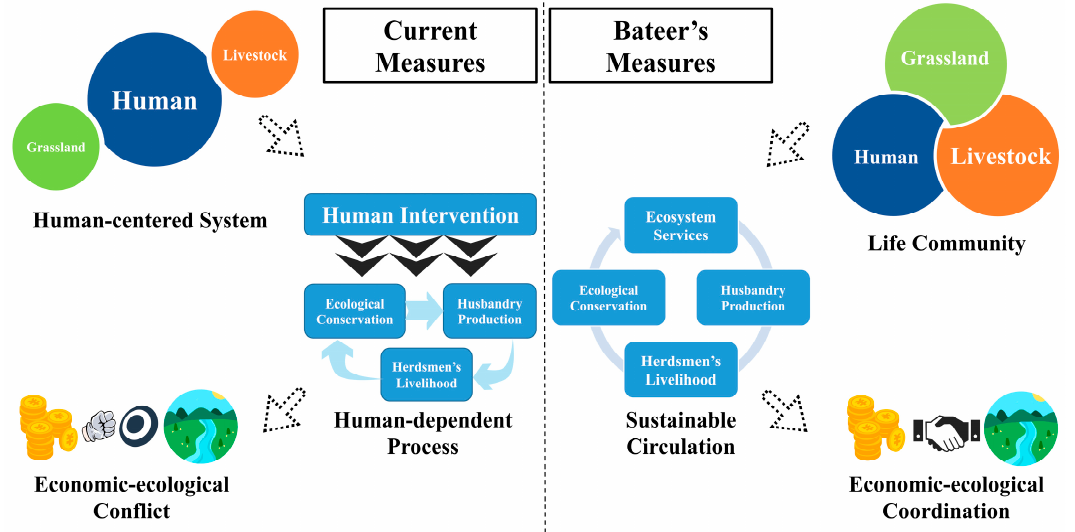
Figure 6. Comparison between human high-intensity intervention (current measures) and the NbS (Bateer’s measures).